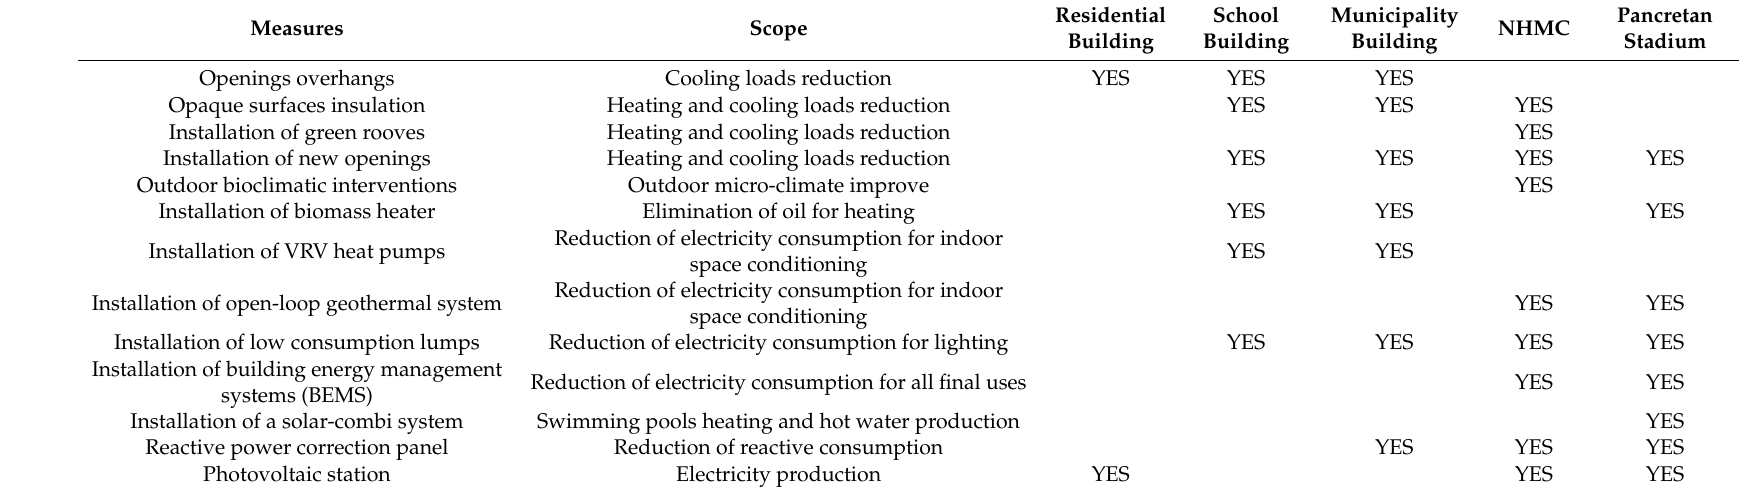
Table 5. Summary of the proposed passive and active systems in the examined